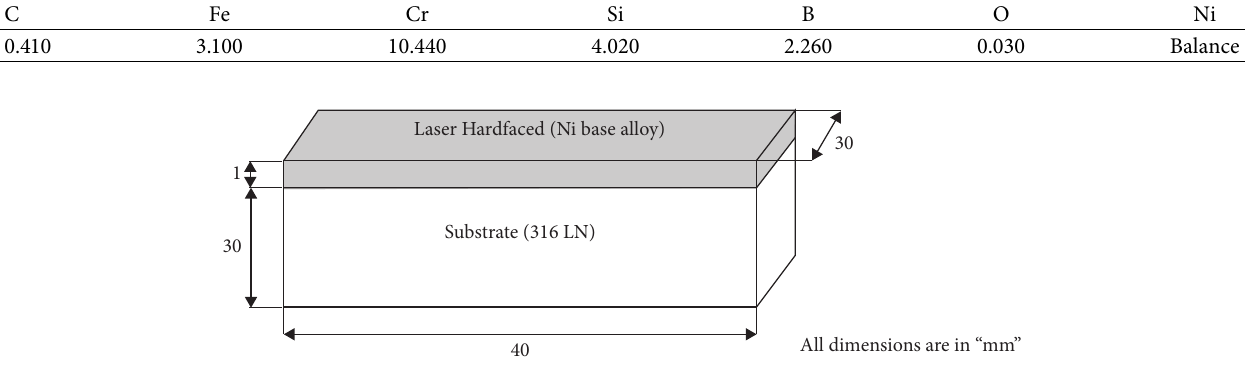
Figure 1: Schematic diagram of single-layer hardfacing. Table 3: The variables of the process parameters and their operating range.